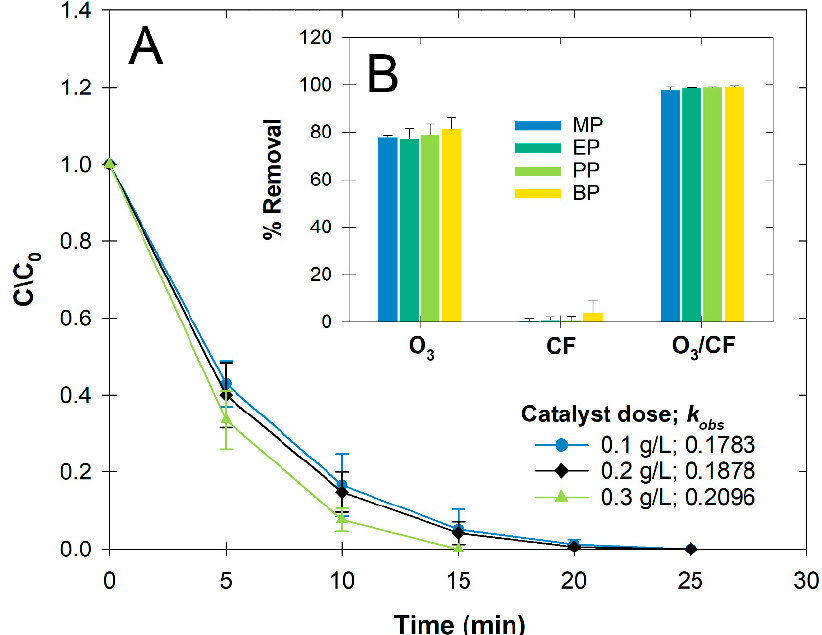
Figure 5. ( A ) Temporal changes of BP at different CF dosages in the O 3 /CF system (Catalyst: 0.2 g L − 1 , [each paraben o ]: 10 µ M, pH 7, 25 ◦ C). ( B ) Paraben removal efficiency at 20 min under different treatments (O 3 , CF, and O 3 /CF), and Error bars indicate ± standard deviation.